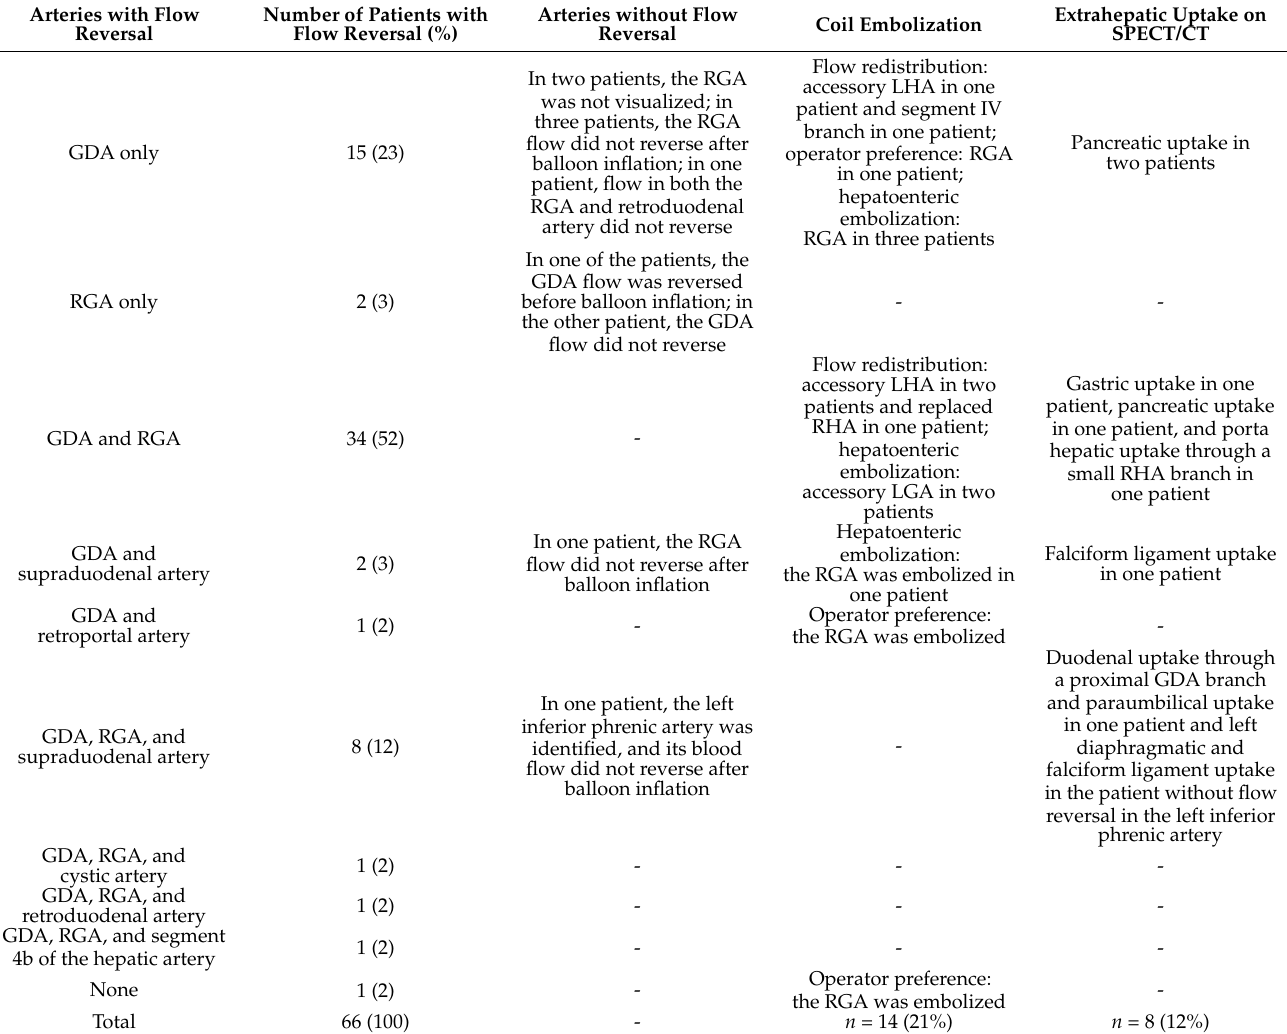
Table 2. Blood flow reversal in hepatoenteric arteries following balloon occlusion during diagnostic arteriography and